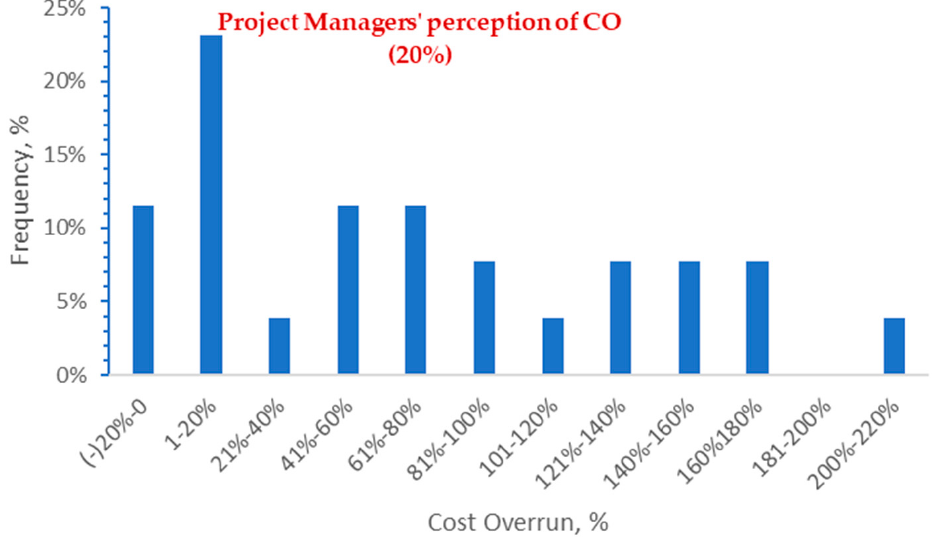
Figure 2. Inaccuracies of construction cost estimates for DB housing projects in reference class.